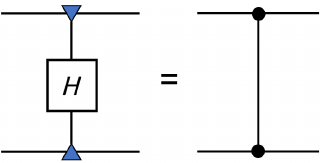
FIG. 16. The triangular tensors are the encoding tensors of the repetition code and H is the tensor that corresponds to the Hadamard or Fourier gate. Right figure represents the gener- alized controlled phase gate, which reduces to the CZ gate on qubits.